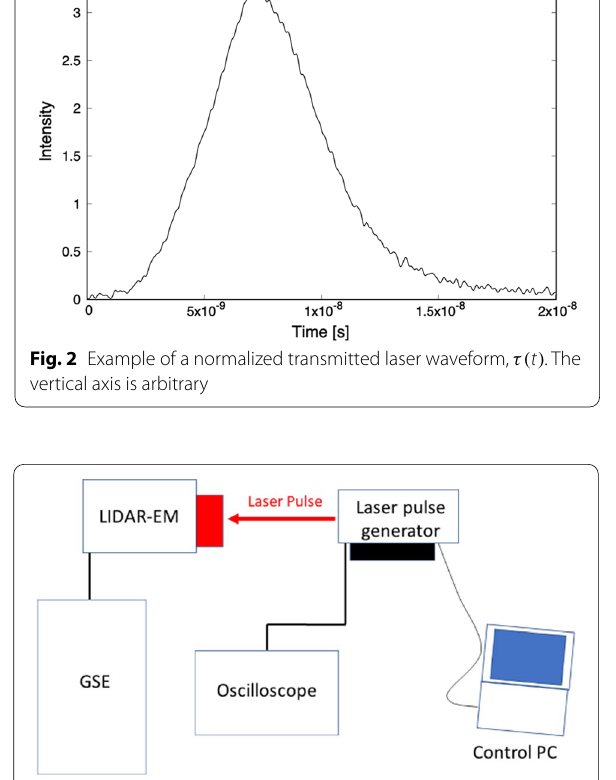
Fig. 3 Schematic diagram of the experimental setup of the